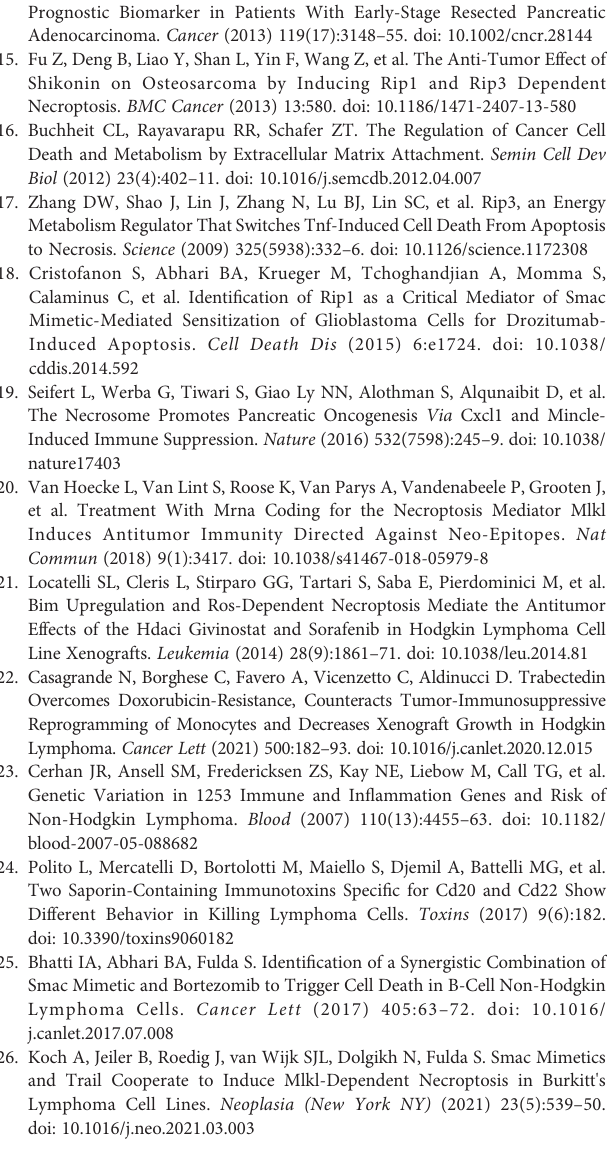
Supplementary Figure 1 | The differential NRGs between the DLBCL and normal cell lines in GSE12195 and GSE56315. Supplementary Figure 2 | K-M survival analysis curve of 25 NRGs in entire cohort. Supplementary Figure 3 | The delta area, consensus CDF by cluster analysis based on DEGs. Supplementary Figure 4 | The drug sensitivity between the low- and high-risk group